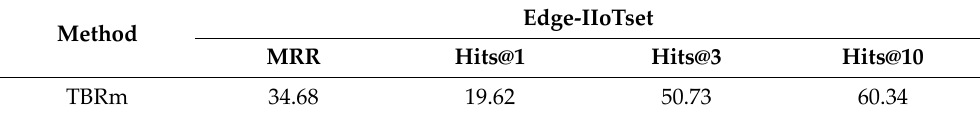
Table 5. The performance of TBRm tested on the Industrial Internet of